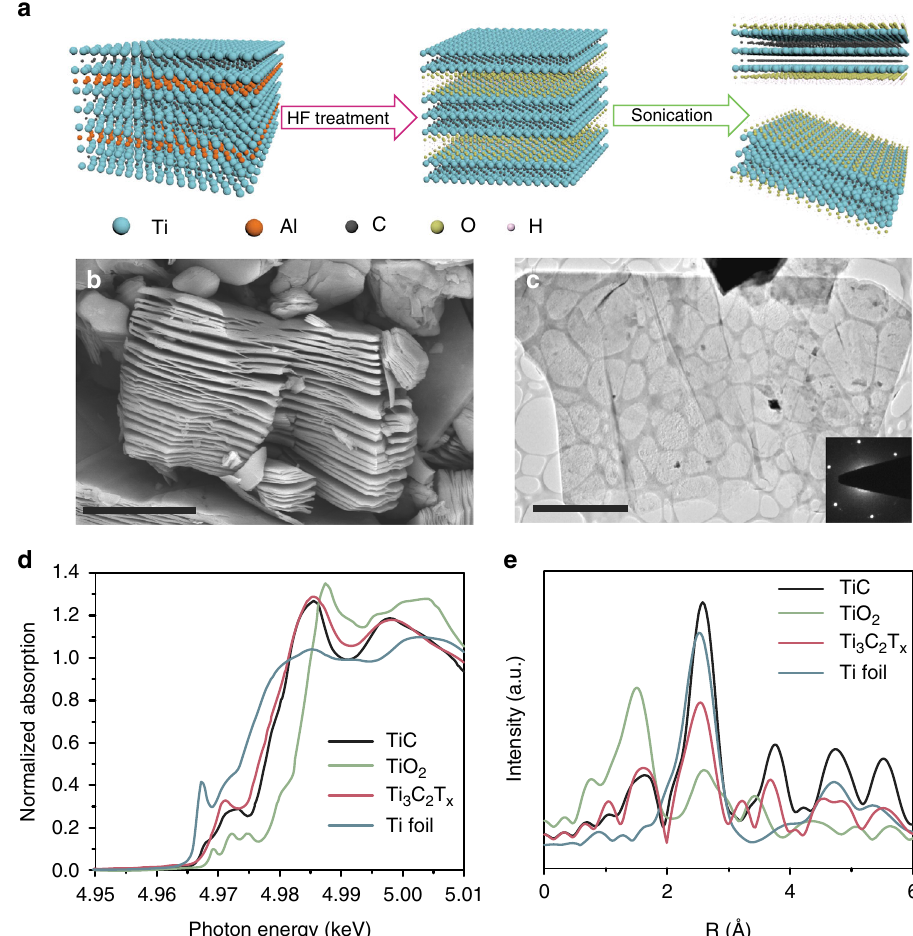
Fig. 1 Characterization of Ti 3 C 2 T x MXene support. a Schematic of Ti 3 C 2 T x MXene preparation. b SEM image of Ti 3 C 2 T x MXene, the scale bar corresponds to 3 µ m. c TEM image of Ti 3 C 2 T x MXene nanosheets. Inset represents the selected area electron diffraction (SAED) pattern showing hexagonal basal plane symmetry of Ti 3 C 2 T x MXene. The scale bar corresponds to 2 µ m. d XANES spectra of the Ti 3 C 2 T x compared to references including Ti metal foil, TiO 2 and TiC. e Magnitude of the Fourier transform of the k 2 weighted EXAFS of the Ti 3 C 2 T x compared to bulk